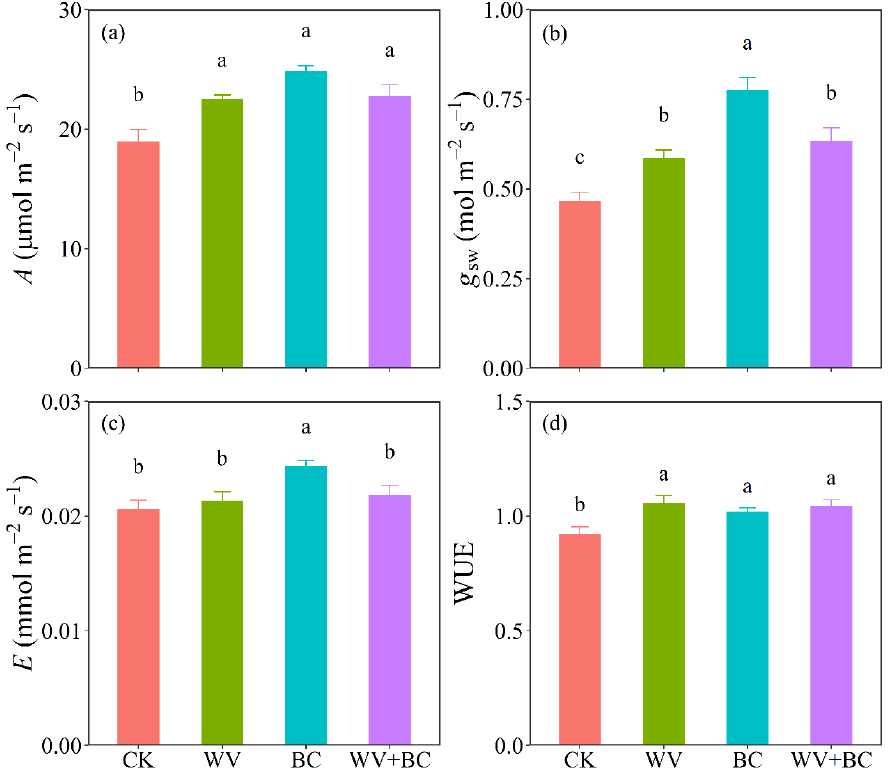
Figure 8. Effects of different seed treatments on ( a ) A , ( b ) g sw , ( c ) E and ( d ) WUE of WDR at heading stage under field experiment. Different letters show a significant difference between treatments at p = 0.05 according to LSD test. Error bars indicate standard error of three replicates. CK: untreated seeds, WV: wood vinegar seed priming, BC: biochar seed coating, WV + BC: co-treatment of wood vinegar priming and biochar coating. A : net photosynthetic rate, E : transpiration rate, g sw : stomatal conductance to vapor diffusion, WUE: water use efficiency ( A / E ).